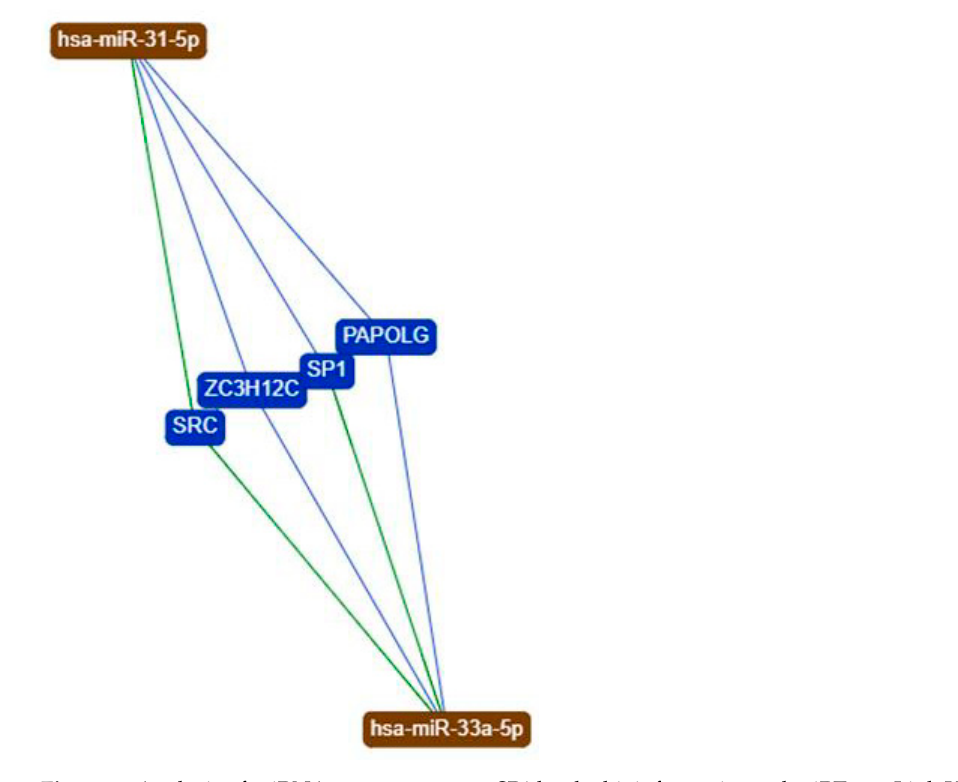
Figure 2. Analysis of miRNAs common target SP1 by the bioinformatics tool miRTargetLink Human. The central node represents Sp1 and other common targets, surrounded by the miRNAs that target Sp1 with strong (green) and weak (blue) evidence.